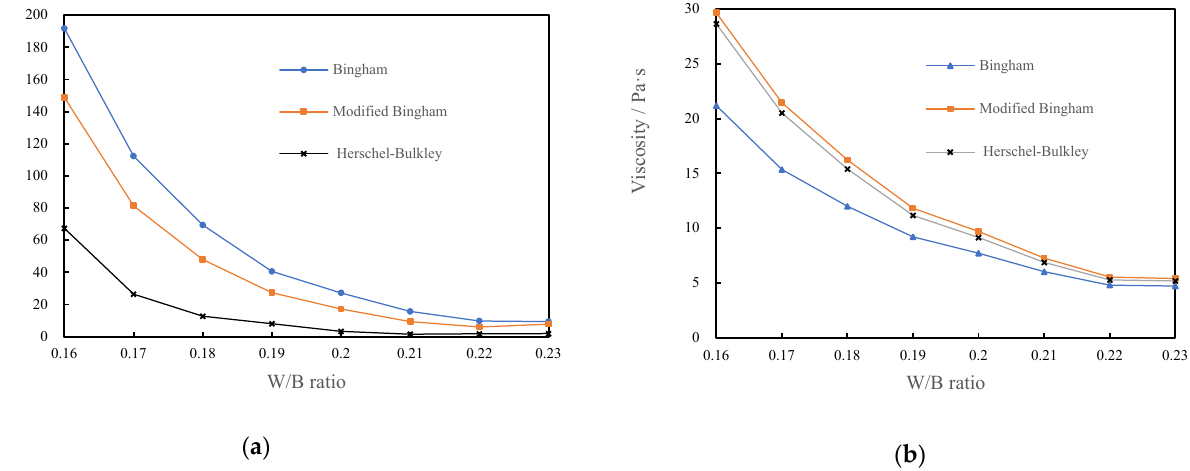
Figure 11. The relationship between the yield stress, plastic viscosity and W/B ratio of CSHWM, ( a ) the yield stress , ( b ) the plastic viscosity .